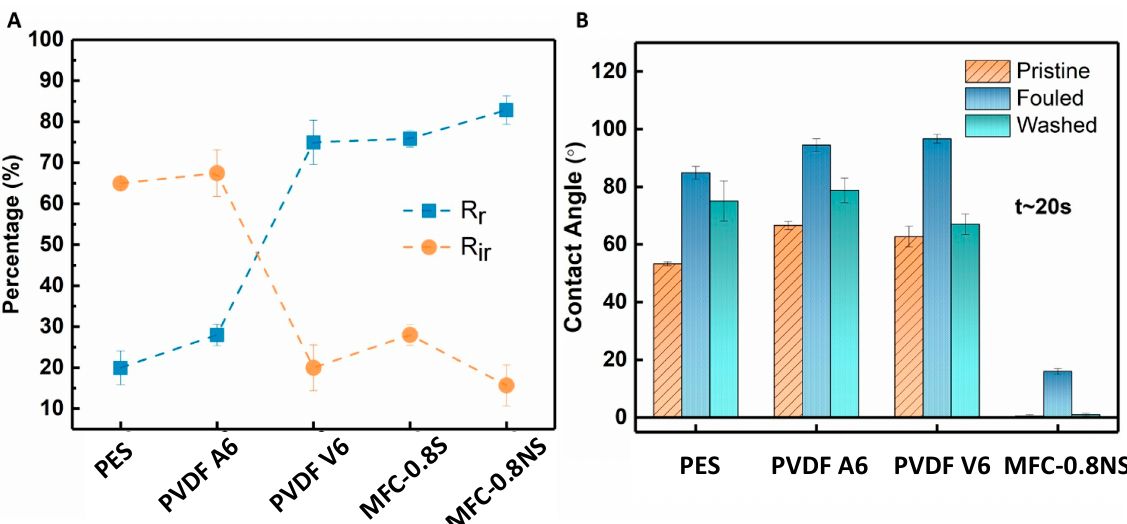
Figure 13. ( A ) Reversible and irreversible fouling ratios and ( B ) contact angle measurements of MFC and commercial membranes.